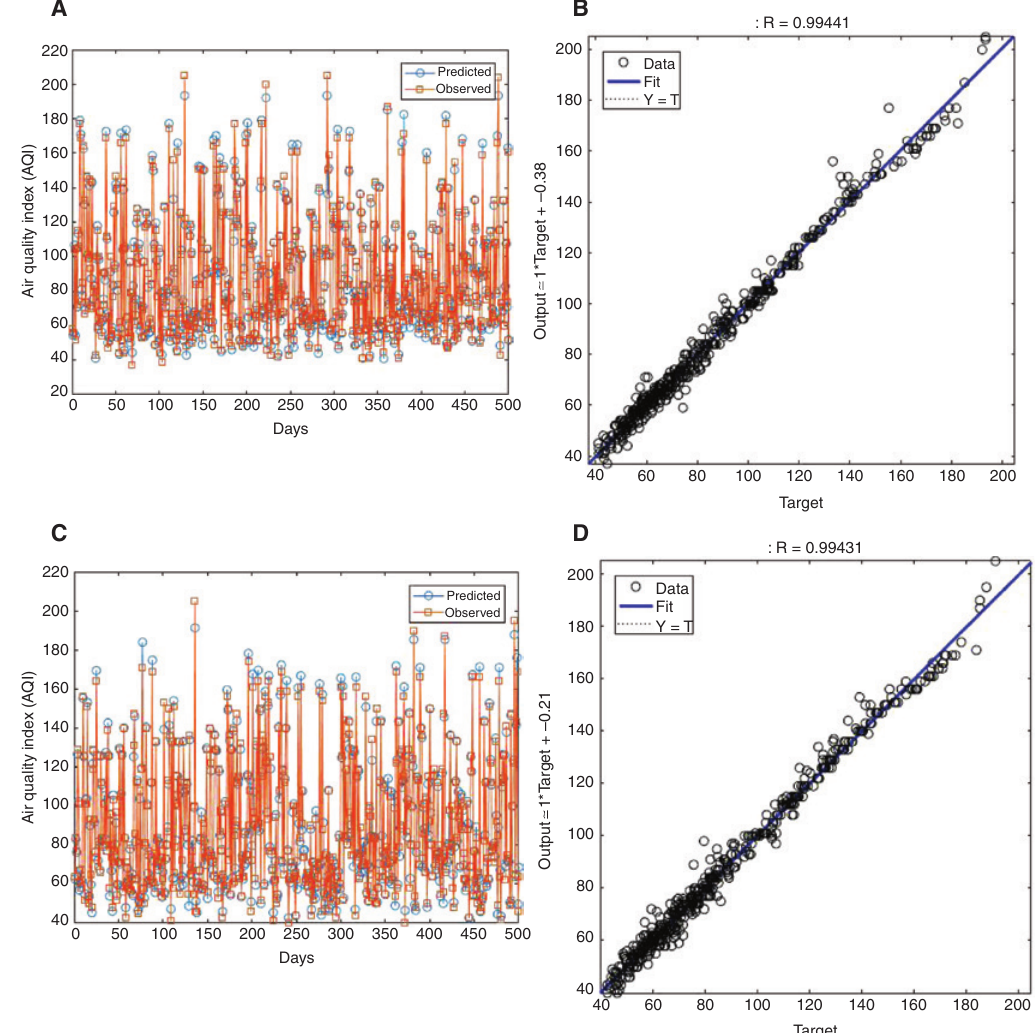
Figure 3: Cascade Forward Ensemble of Neural Network Predictors: (A) Testing Plot for Houston, (B) Regression Plot for Houston, (C) Testing Plot for Los Angeles, and (D) Regression Plot for Los